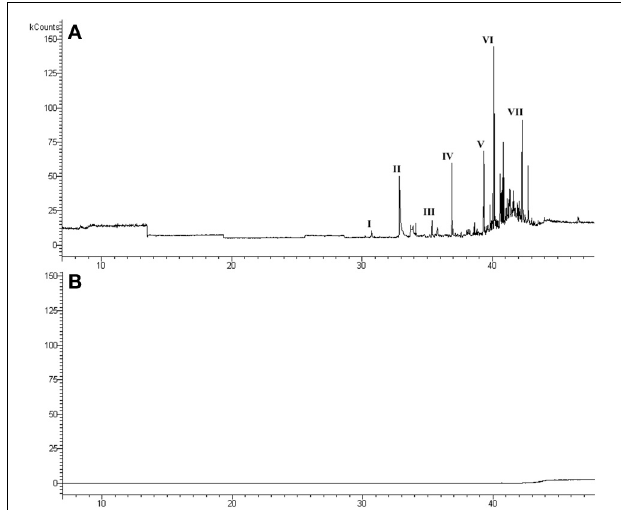
FIGURE 1 | Chromatogram of urine (A) and MUP stripped of ligands (B), used in the behavioral tests. Main GC/MS identifications in chromatogram (a): (I) 2,4-dehydro- exo -brevicomin (identified by matching with a chemical standard); (II) 2- sec -butyl-4,5-dihydrothiazole (standard); (III) 2,4-dimethyl-phenol (standard); (IV) 4-ethyl-phenol (standard); (V) indole (standard); (VI) 2-butyl-1-octanol (standard); (VII) 2-ethyl-1-decanol (83, 23% library matching).